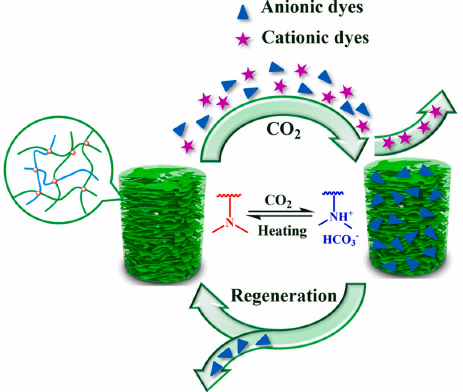
Figure 4. CO 2 − responsive cellulose nanofiber aerogel with a controlled and recyclable dye removal process stimulated by CO 2 [105] .